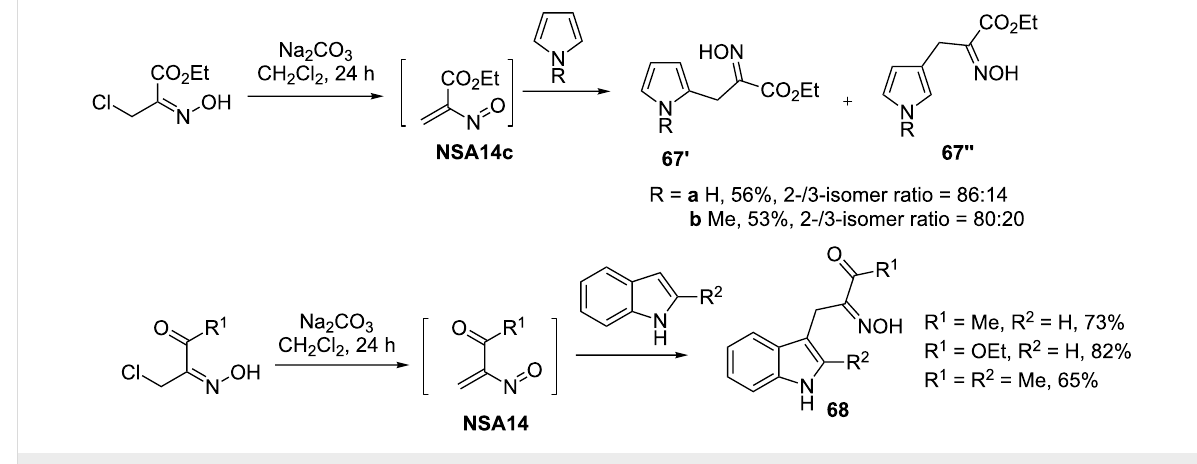
Scheme 23: Addition of nitrosoalkenes NSA14 to pyrroles and indoles.